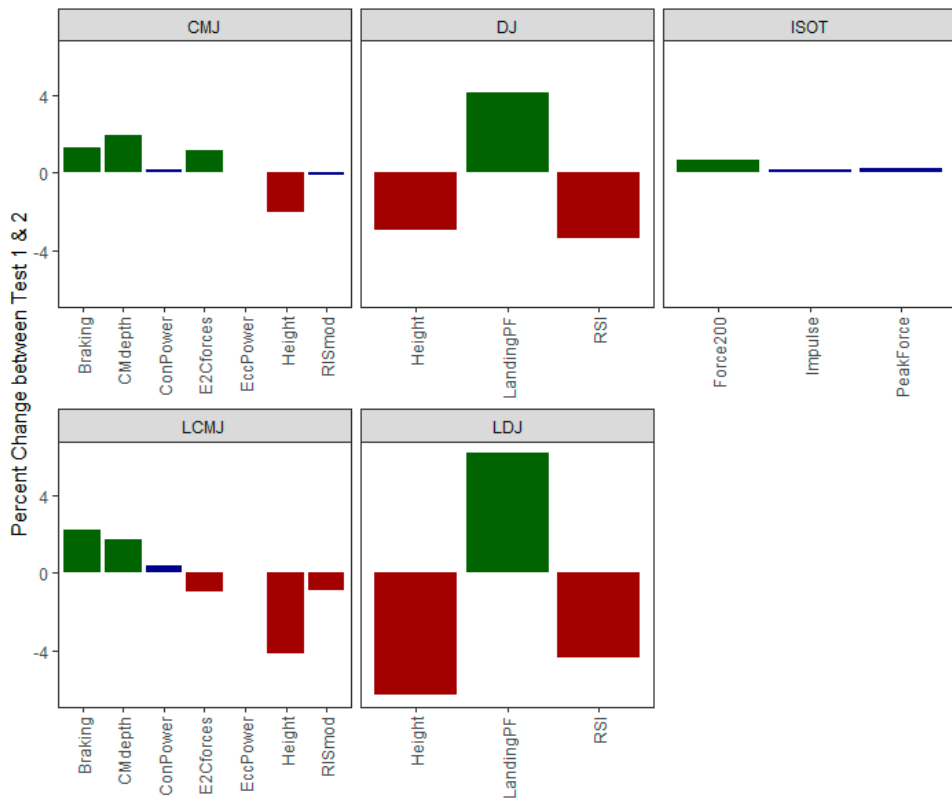
Figure 8. Example of percent change plots for monitoring neuromuscular fatigue across weekly to bi-weekly training. bi-weekly training. CMJ, countermovement jump; LCMJ, loaded CMJ; DJ, drop jump; LDJ, loaded CMJ, countermovement jump; LCMJ, loaded CMJ; DJ, drop jump; LDJ, loaded DJ; ISOT, isometric strength test. DJ; ISOT, isometric strength